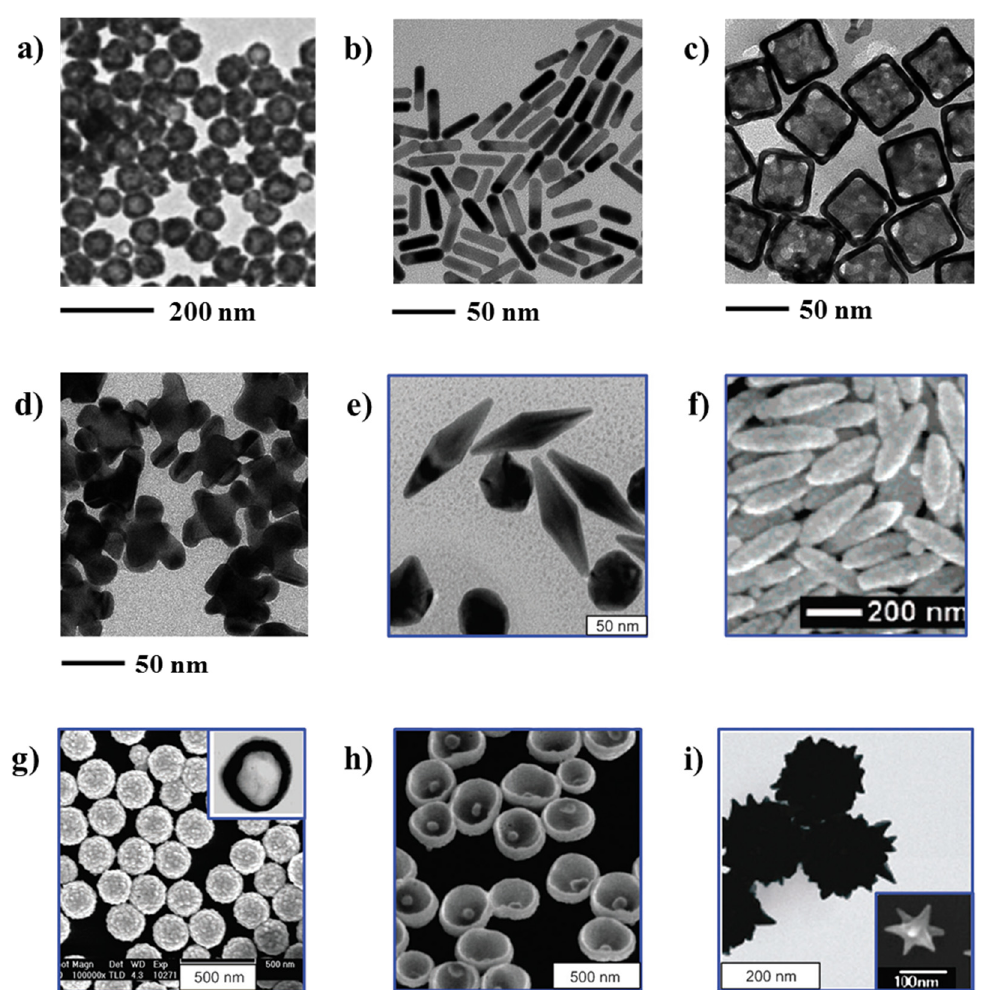
Figure 4. TEM images of di ff erent types of gold nanoparticles: ( a ) gold nanospheres; reprinted with permission from [30]; copyright (2005) American Chemical Society; ( b ) gold nanorods; reprinted with permission from [31]; copyright (2013) American Chemical Society; ( c ) gold nanocages; reprinted with permission from [31]; ( d ) gold nanohexapods; reprinted with permission from [31]; ( e ) gold bipyramids; reprinted with permission from [32]; copyright (2005) American Chemical Society; ( f ) “nanorice” (gold-coated Fe 2 O 3 nanorods); reprinted with permission from [33]; copyright (2006) American Chemical Society; ( g ) SiO 2 / Au nanoshells (the inset shows a hollow nanoshell); reprinted with permission from [29]; copyright (2010) Elsevier; ( h ) nanobowls with bottom cores; reprinted with permission from [34]; copyright (2009) American Chemical Society; ( i ) spiky SiO 2 / Au nanoshells (reprinted with permission from [35]; copyright (2010) American Chemical Society; the inset shows a gold nanostar); reprinted with permission from [36]; copyright (2006) American Chemical Society.